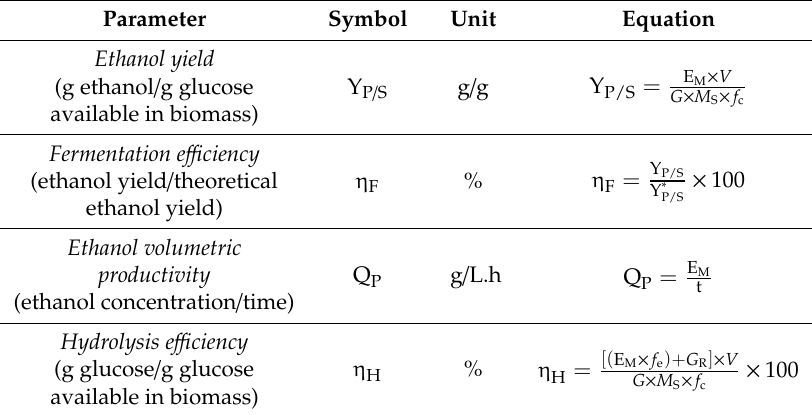
Table 4. Equations used for calculation of the parameters in the SSF